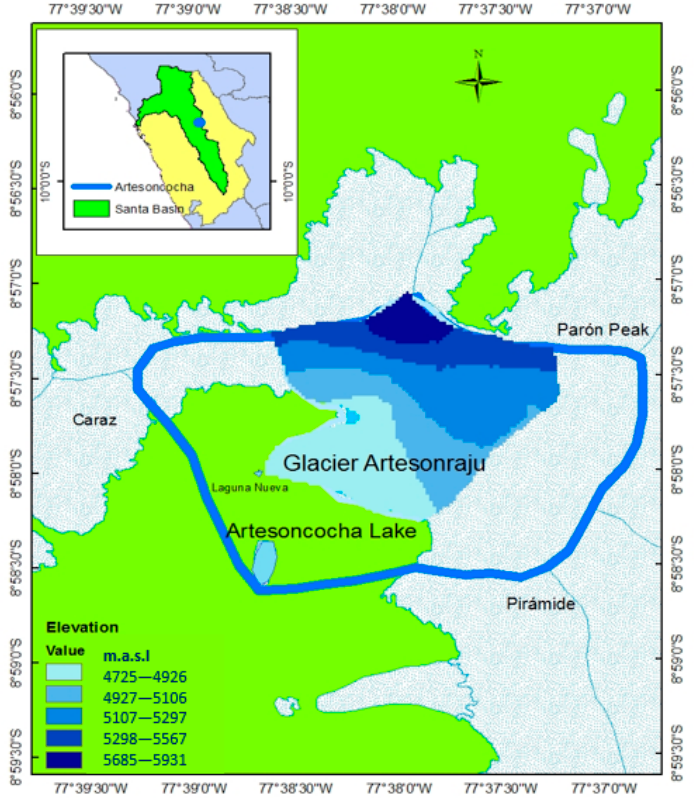
Figure 1. Locations of glacier Artesonraju, Artesoncocha basin limits, and Artesoncocha lake.